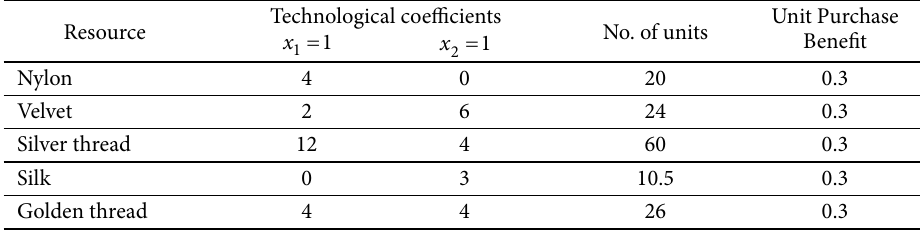
Table 2. Modified example to demonstrate Yu’s model Resource